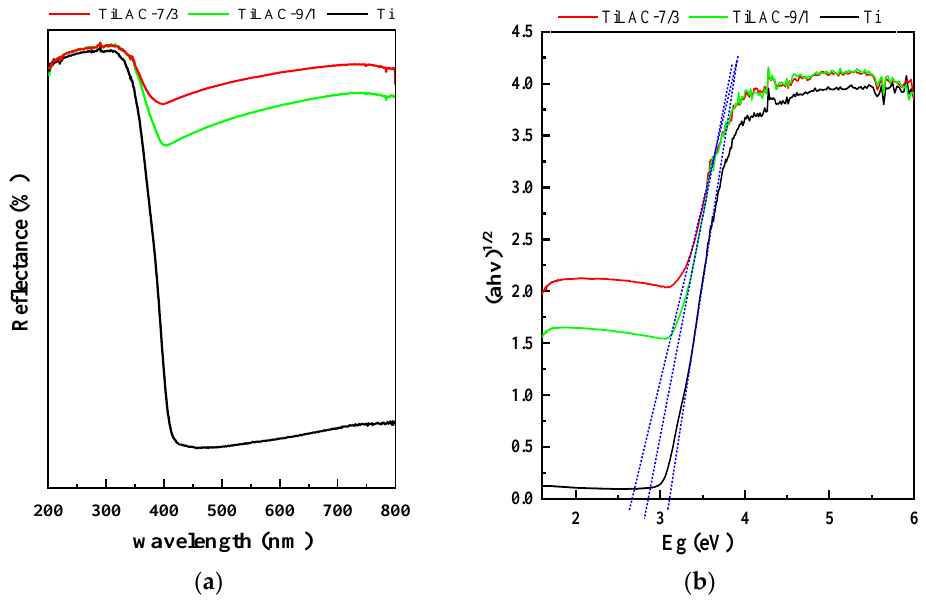
Figure 6. ( a ) UV-visible diffuse reflectance spectra and ( b ) energy band-gap vs (ah ʋ ) 1/2 of Ti; TiLAC-7/3 and TiLAC-9/1.